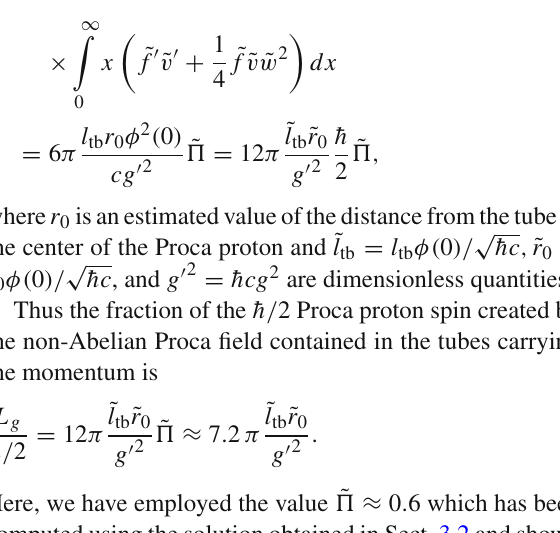
‘quarks’ filled with the Proca field, which we have considered in Secs. 4.1 and